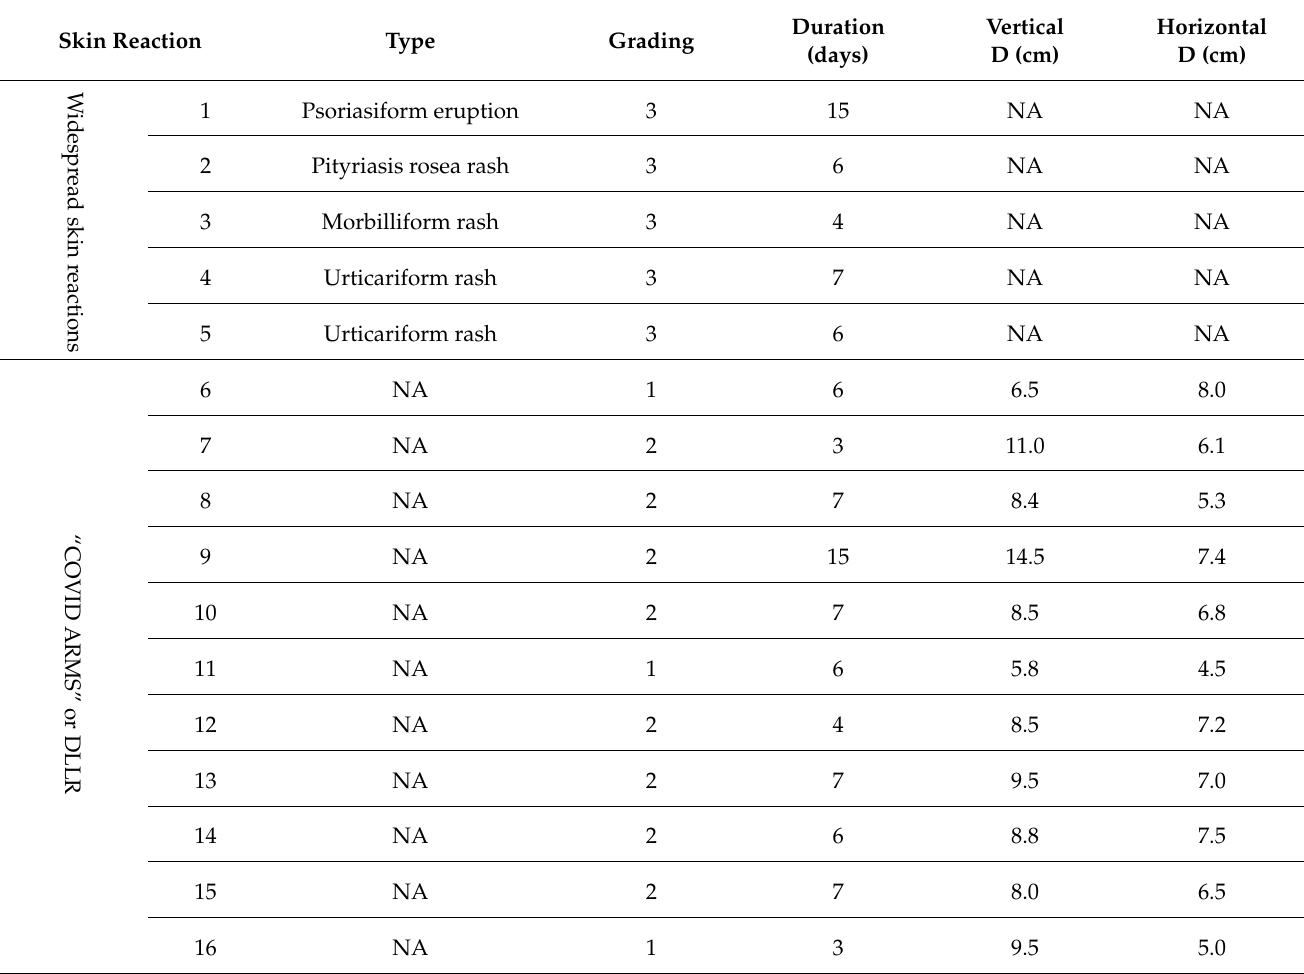
Table 3. Clinical characteristics of skin-tested patients.